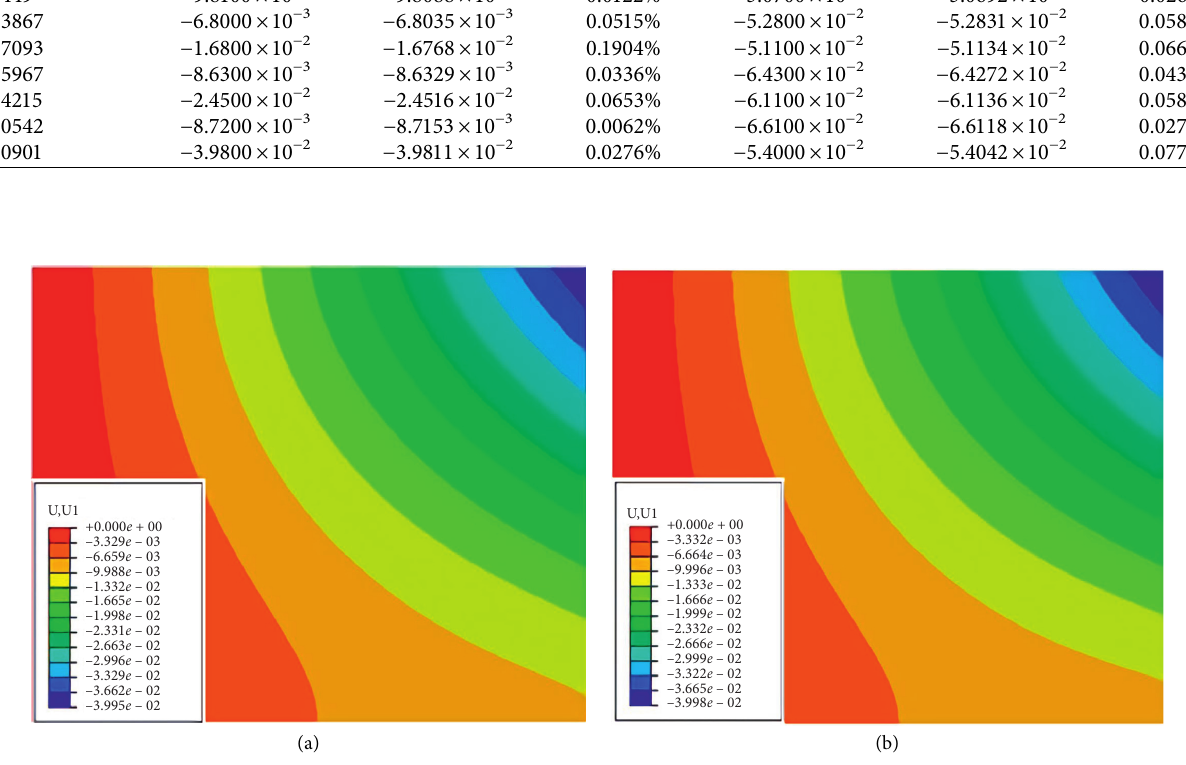
Figure 4: The distribution nephogram of horizontal displacement (m).